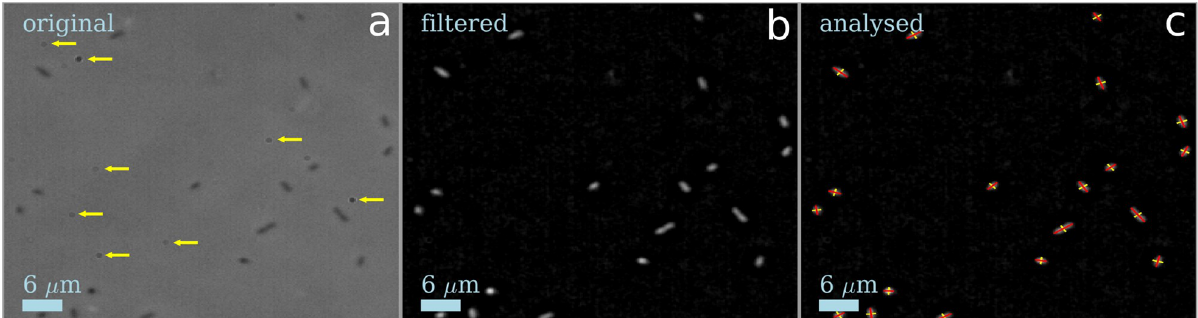
Fig 1. Identifying bacteria on surface. (a) Part of an original image as obtained with phase contrast microscopy, dark signal indicates objects that are in focus. The yellow arrows indicate artefacts produced by dust in the optical path, here from the glass cover protecting the camera chip. (b) The same image after artefact removal, black/white inversion, Gaussian blurring, local background subtraction and intensity renormalisation. (c) Bacteria with their long (red) and short (yellow) axes determined.